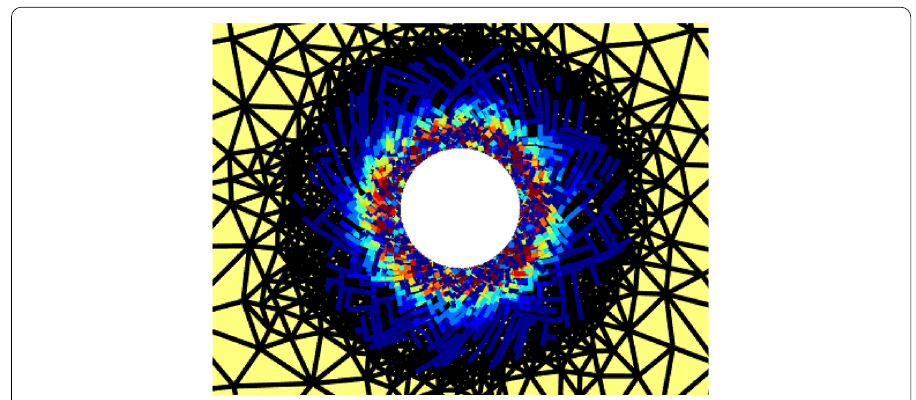
Fig. 9 Detail of adaptively refined front mesh (black) and damage values along fracture surfaces (color) near the wellbore at t ≈ 37 . 5 μ s. Damage in the range, D ∈ [0 , 1], maps to a blue-to-red color range with red indicating full